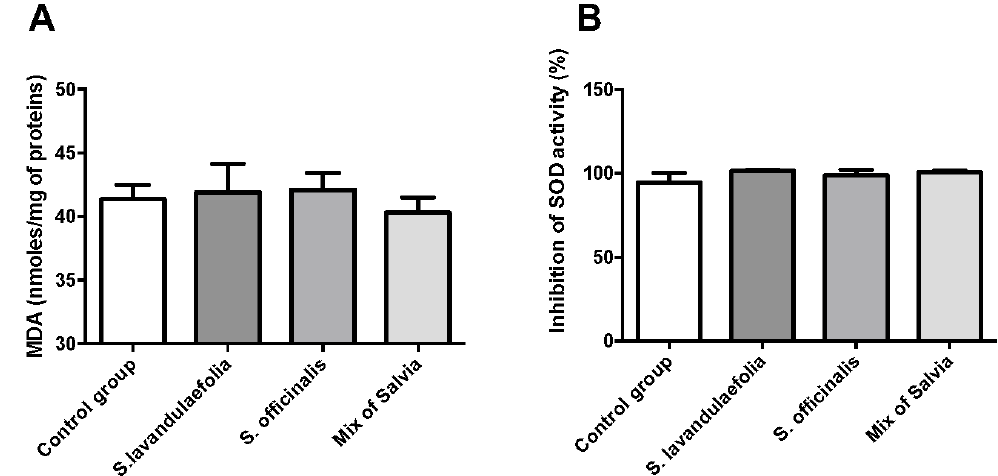
Figure 4. Chronic mix of Salvia supplementation did not impact oxidative stress. ( A ) Evaluation of